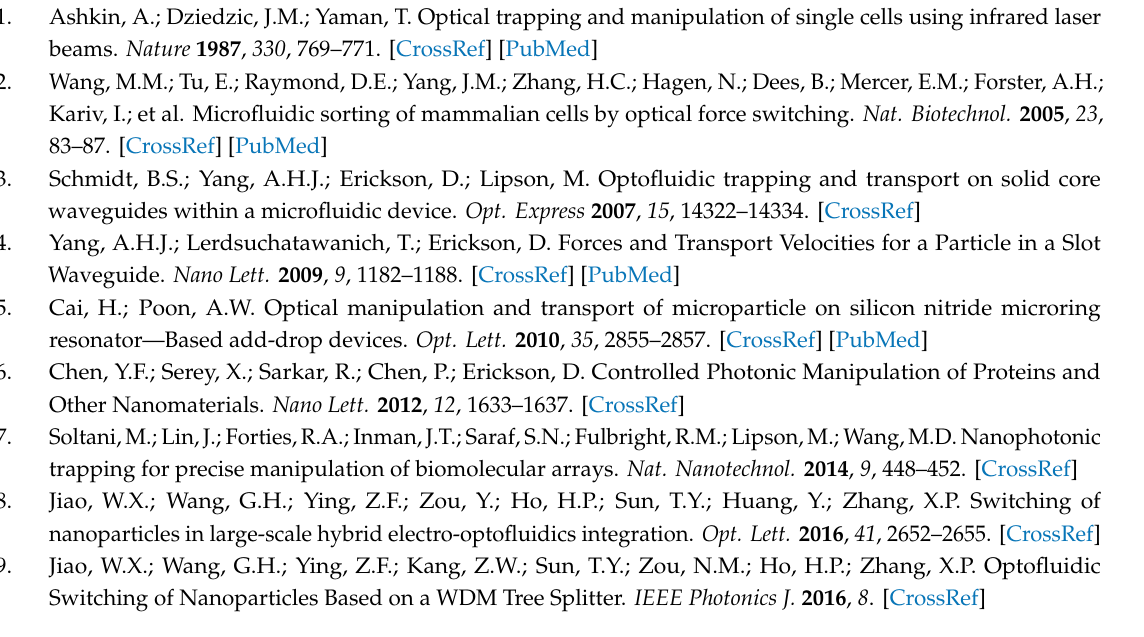
Video S1: Refer to Figure 5a, Video S2: Refer to Figure 5b, Video S3: Refer to Figure